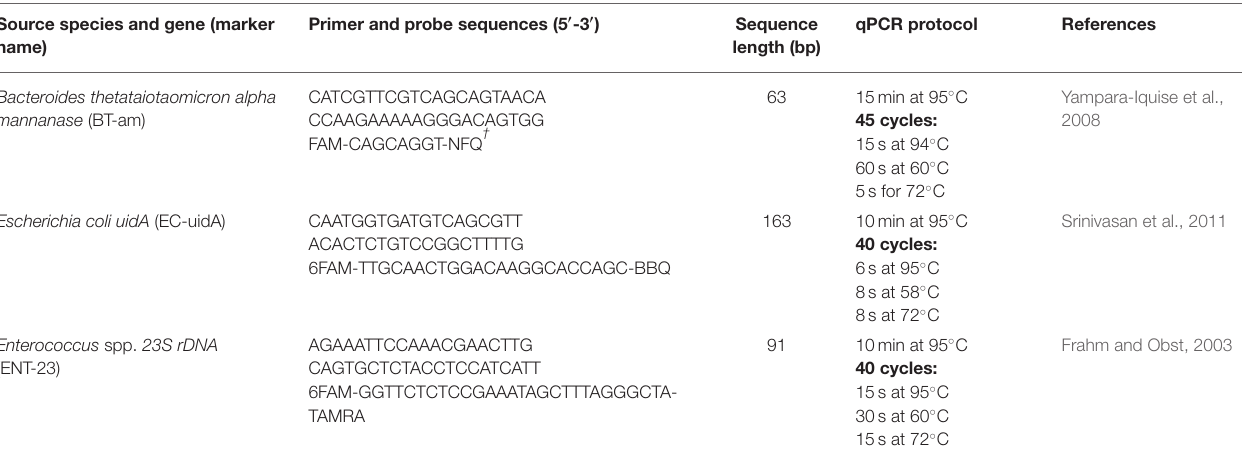
TABLE 1 | Details of the qPCR assays (primers, probes, amplified sequence length, and qPCR protocols) of the genetic markers, enterococci 23S rDNA (ENT-23), Escherichia coli uidA (EC-uidA), and Bacteroides thetataiotaomicron alpha mannanase